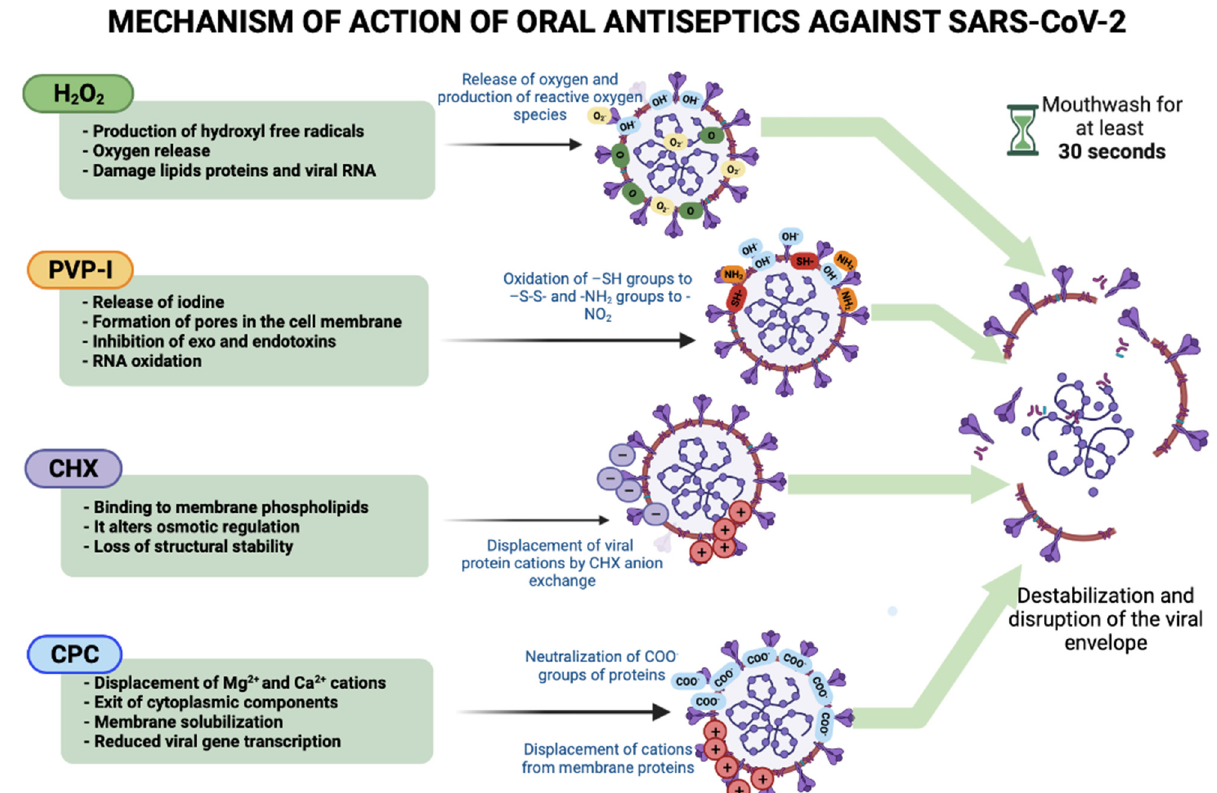
Figure 1. Mechanism of oral antiseptics. Hydrogen peroxide (H 2 O 2 ) produces hydroxyl free radicals and reactive oxygen species that react with lipids, proteins, and RNA. Povidone–iodine (PVP-I) oxides –SH groups to –S–S– and –NH 2 groups to –NO 2 . Chlorhexidine (CHX) binds to membrane phospholipids and displaces viral protein cations by CHX anion exchange. Cetylpyridinium chloride (CPC) displaces cations and neutralizes negative -COO - charges of proteins, which breaks the viral membrane. Figure created with BioRender, biorender.com.